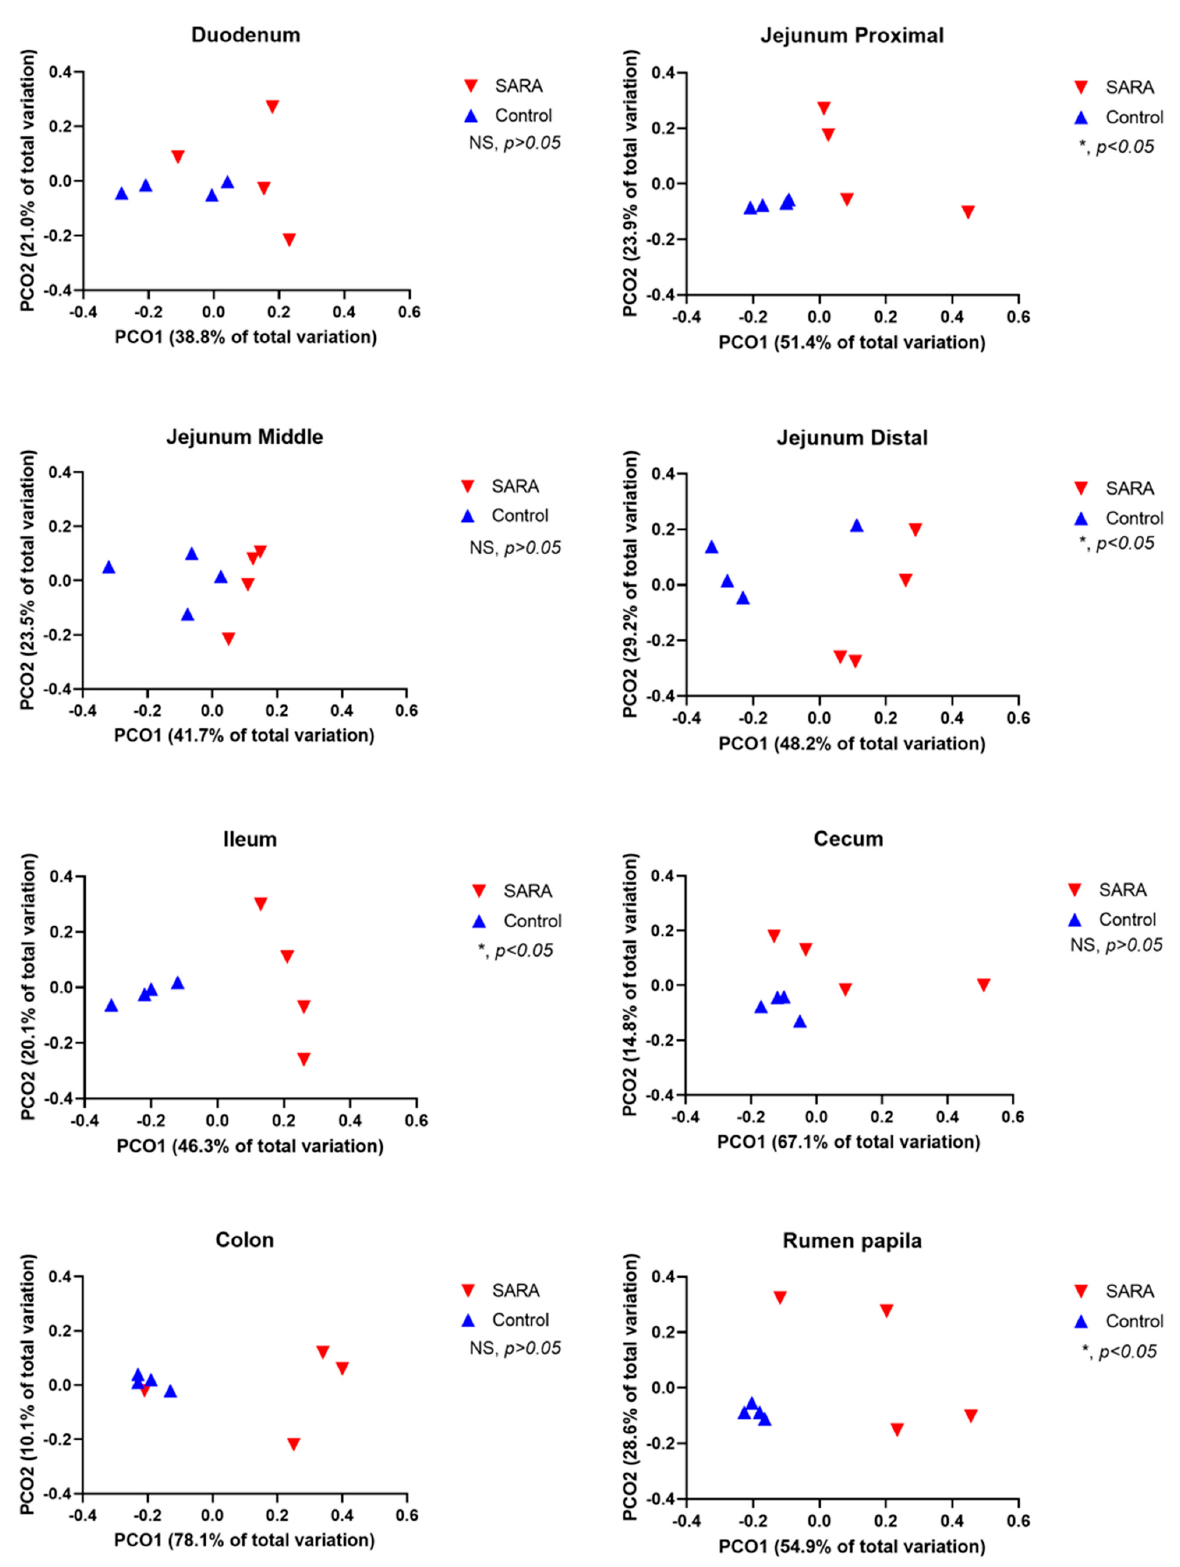
Figure 1. Principal coordinate analysis (PCoA) of unweighted UniFrac distances of treatments (C = control, S = SARA) by site in the digestive tract.